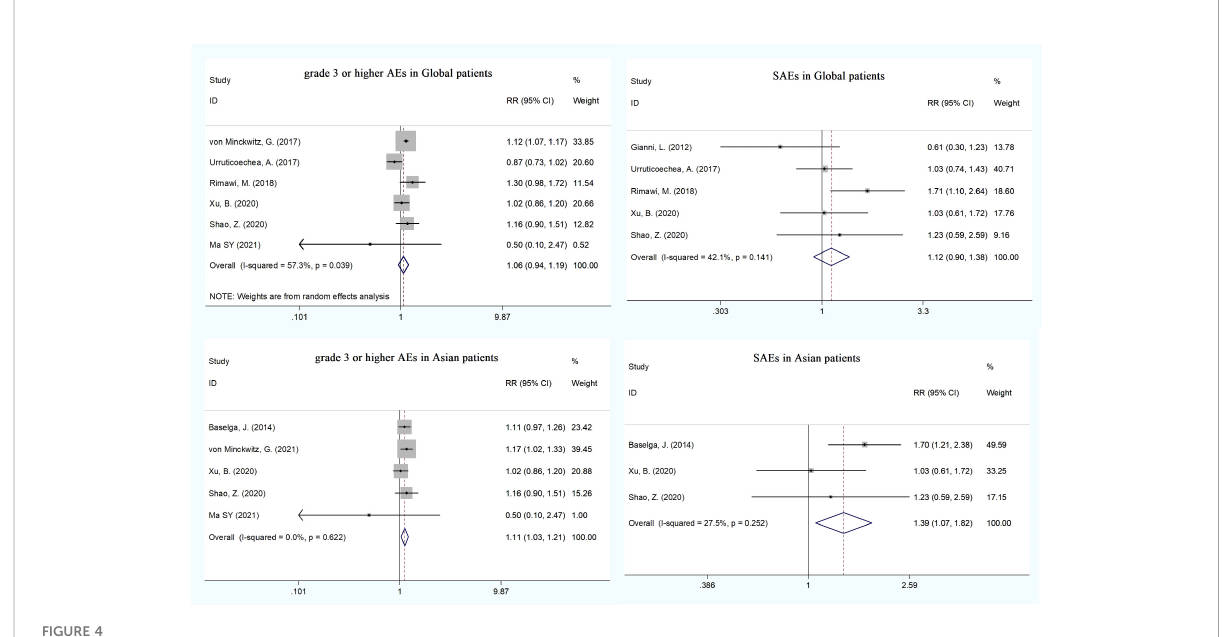
FIGURE 4 The incidence of total grade = 3 AEs and SAEs between the dual anti-HER2 therapy group (pertuzumab plus trastuzumab) and the monotherapygroup in global and Asian